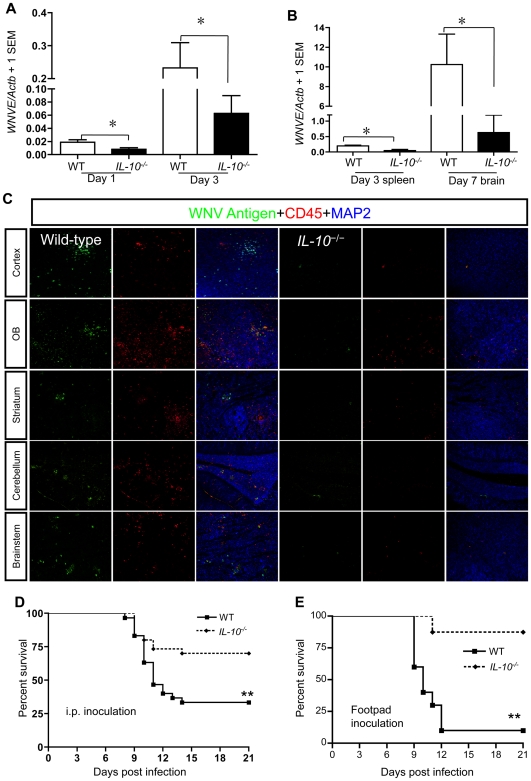
IL-10 signaling facilitates WNV infection.Wild-type (WT, C57BL/6) or IL-10−/− mice were i.p. challenged with WNV (LD50). (A), Q-PCR was performed for WNVE in peripheral blood on days 1 (IL-10−/− mice, n = 14 and WT mice, n = 10) and 3 (IL-10−/− mice, n = 14 and WT mice, n = 9) p.i.. (B), Q-PCR was performed for WNVE in spleens on day 3 (n = 5/group) and brains on day 7 (IL-10−/− mice, n = 7 and WT mice, n = 9) p.i.. (C), Perfused brains were isolated on day 7 p.i., and WNV antigen (green signal), CD45 (leukocyte common antigen, red signal) and neurons (MAP2, blue signal) were detected by confocal microscopy (OB: Olfactory bulb). These images represent 9 mice per group in 3 independent experiments. (D), Kaplan-Meier survival analysis of IL-10−/− and WT mice after i.p. inoculation of WNV (n = 30/group). Data shown are pooled from 3 independent experiments. (E), Survival analysis after WNV inoculation by footpad injection (IL-10−/− mice, n = 8 and WT mice n = 10). Data (means+1 SEM) are pooled results from 2–3 similar independent experiments. *p<0.05 and **p<0.01, compared to control mice.